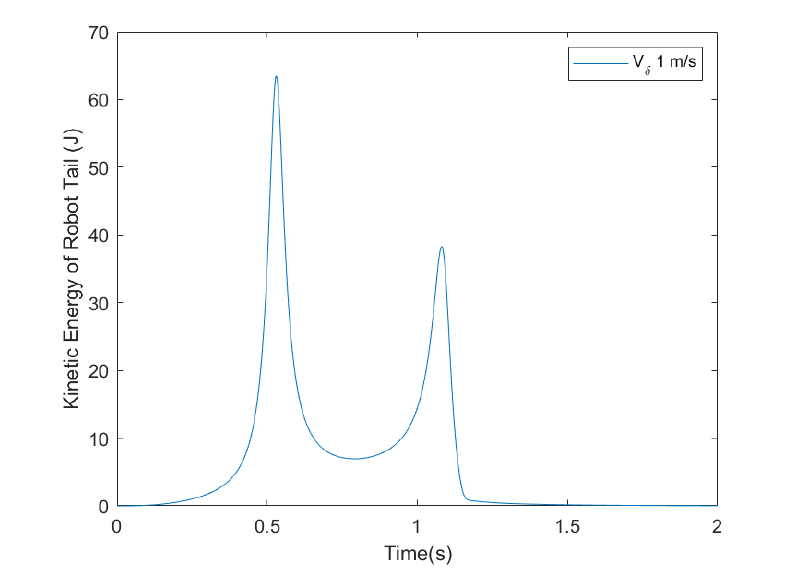
Figure 11. Robot stabilization using tail dynamics: ( A ) without virtual torque estimator. ( B ) With virtual torque estimator in trajectory generation (using end effector linear motion) when subjected to an impulse of 2.5 Nm-s.